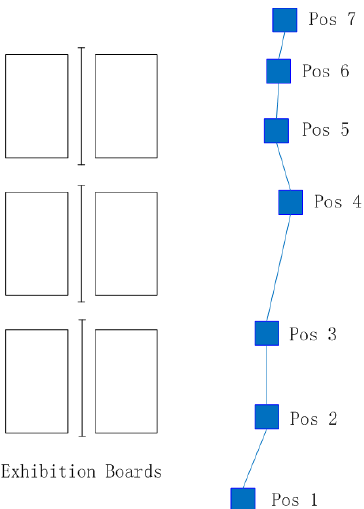
Fig. 4 The top-down view of the extracted positions of cameras from the input image